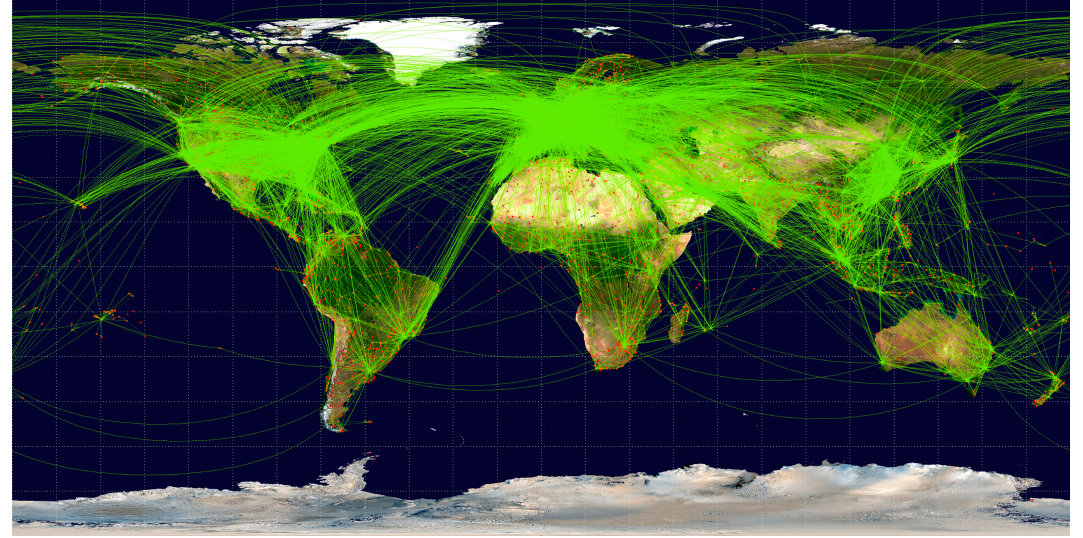
Figure 1. The area around Eyjafjallajökull some seven months after the eruption. Photo: the author.